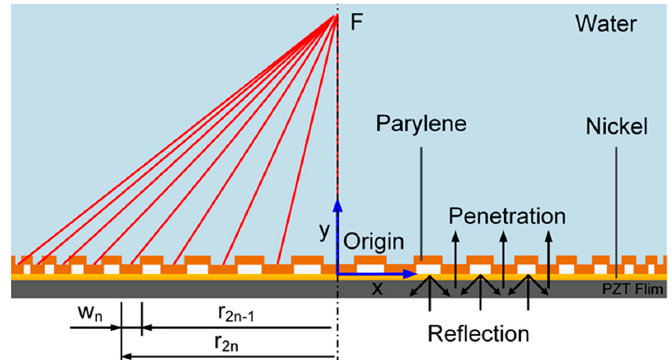
Figure 1. Schematic of the acoustic tweezers with a Fresnel lens. Parylene is deposited on a PZT transducer and patterned according to the FHWB theory. Based on the acoustic impedance theory, the acoustic wave from the PZT transducer transmits through the parylene region to the water and reflects mostly at the air region. The patterned parylene membrane is oriented on the x-axis of the coordinate system.